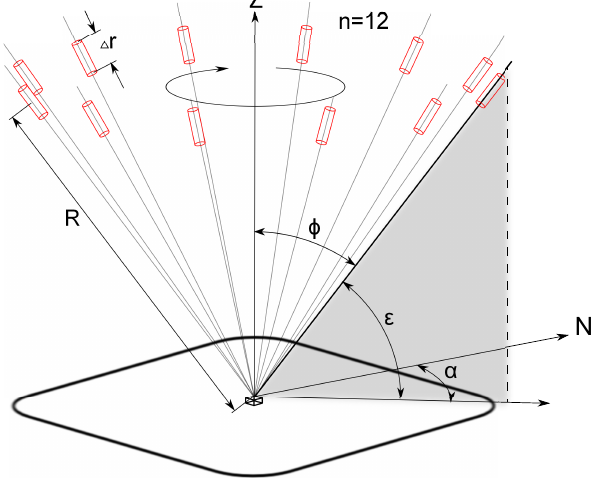
Figure 1. Example of a velocity-azimuth display (VAD) scan- ning technique for n = 12 beam directions. The laser beam of the Doppler lidar points upwards with a constant elevation angle ε and rotates around the vertical Z with configurable azimuth angles α . The red volumes symbolize an emitted “light”-disturbance of a specified period of time (i.e. pulse width (cid:49)t ) travelling along the line-of-sight (LOS). R is the range of the measurement along LOS and (cid:49)r defines the pulse length. The latter is related to the pulse width via (cid:49)r = c · (cid:49)t/ 2, with c denoting the speed of